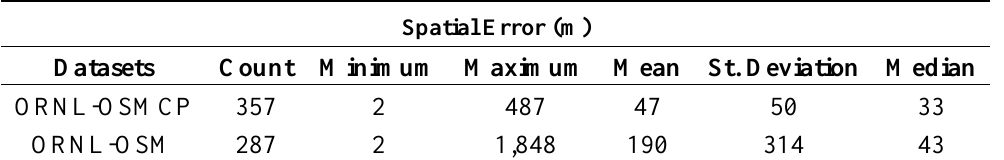
Table 5. Spatial error for matched